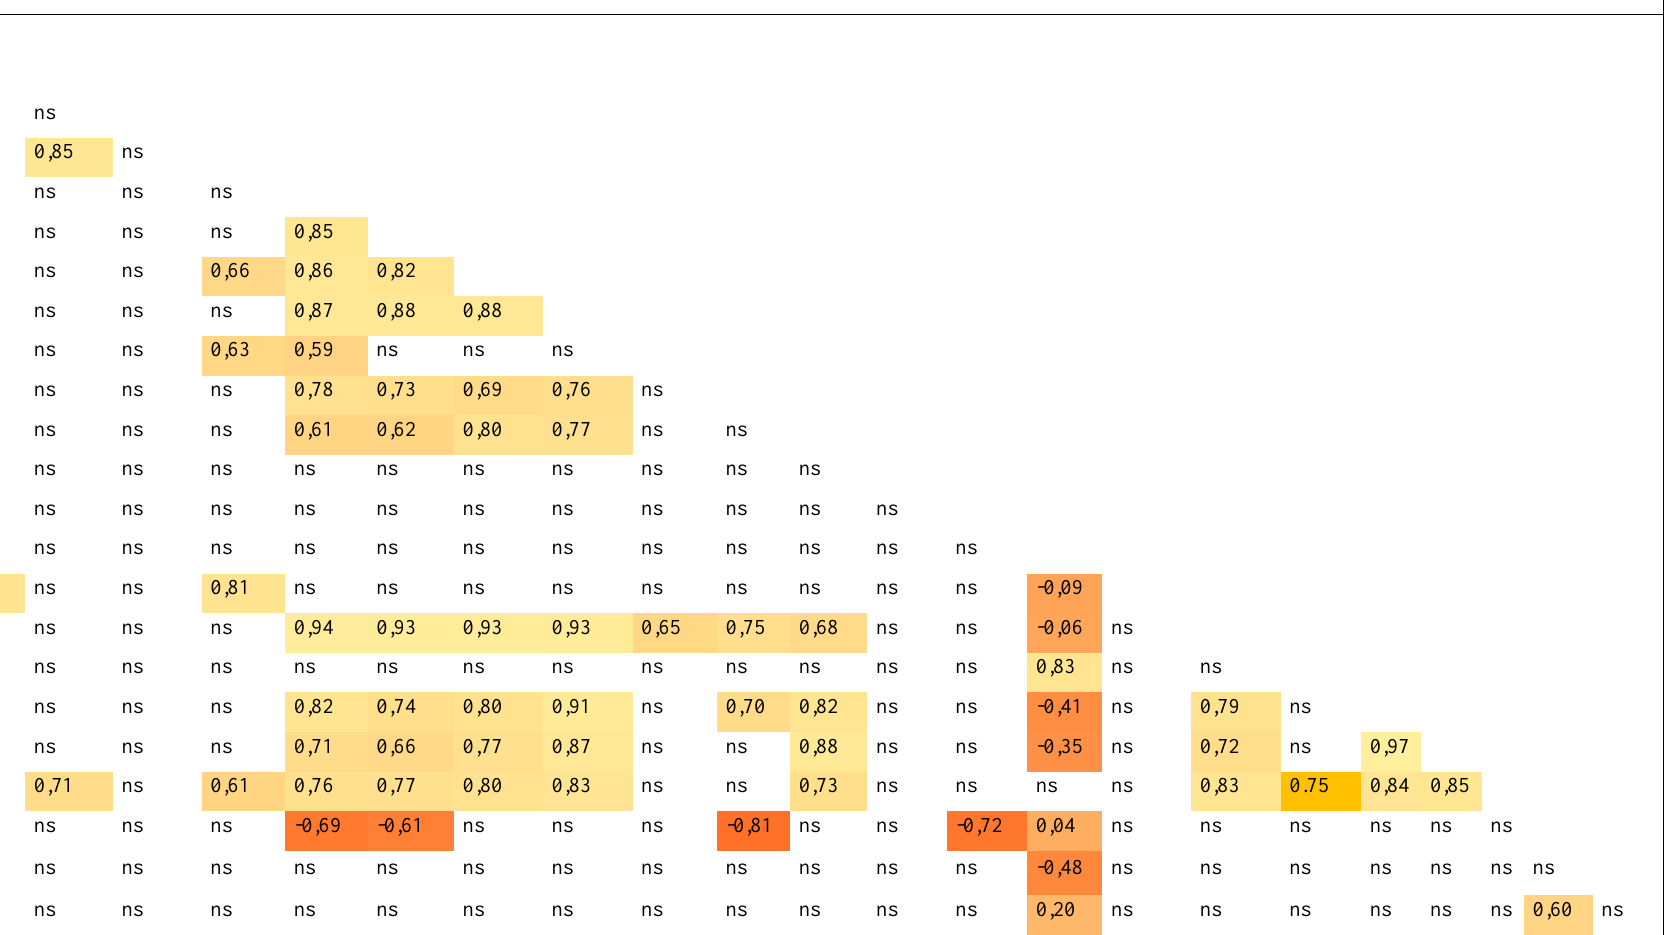
Table 3: Correlation matrix of the biochemical parameters and reproductive indices of Mactra stultorum and the environmental condition. PROFT PROGV PROMT PROAM PRORE GLYFT GLYGV GLYMT GLYAM GLYRE LIPFT LIPGV LIPMT LIPAM LIPRE PROWB GLYWB LIPWB CI GSI PE T (°C) Chlo